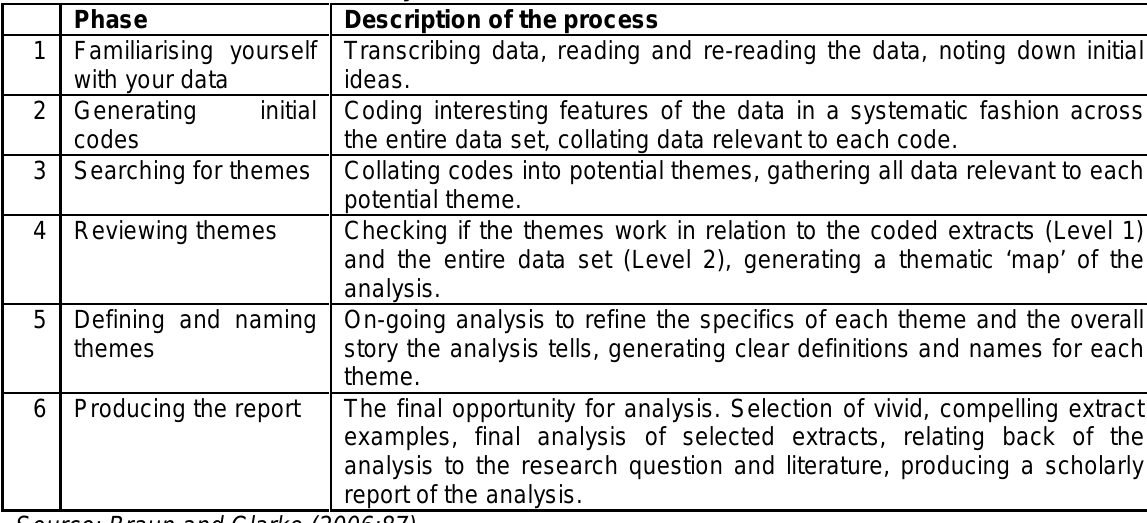
Table 2: Phases of thematic analysis Phase Description of the